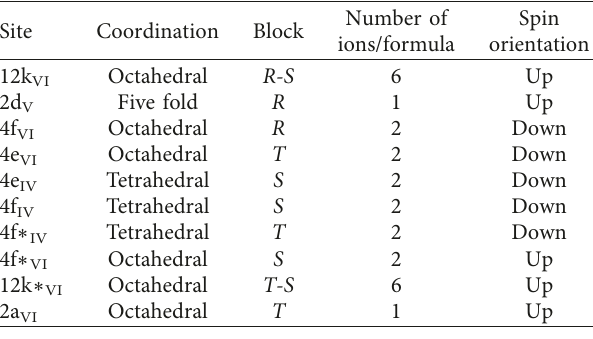
Table 4: Crystallographic sites of small metal ions in Z-type baruim ferrite, their coordination, position in the unit cell, occupancy, and spin orientation of magnetic ions in the site